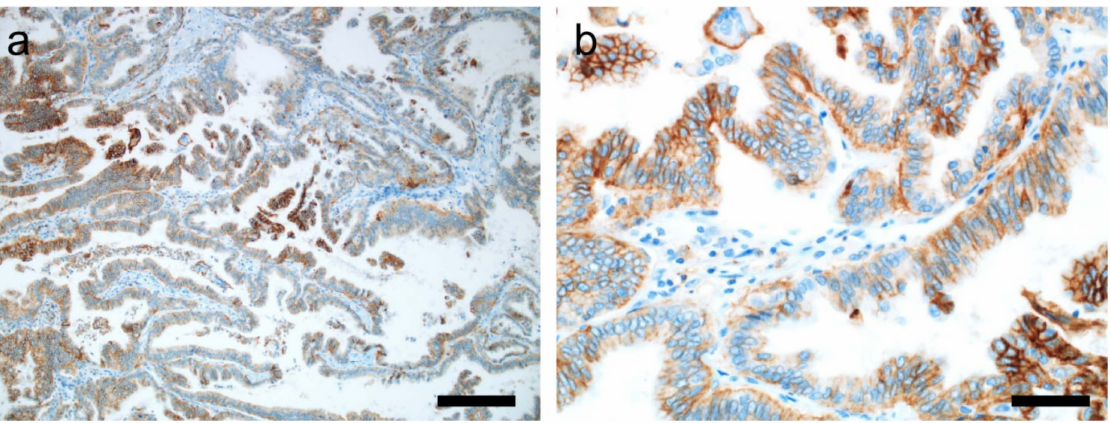
Figure 6. PD-L1 expression in papillary thyroid carcinoma. ( a ) Diffuse expression of PD-L1 on tumor cells ( × 100). ( b ) A high-power view shows the membranous staining for PD-L1 in cancer cells ( × 400). Scale bar = 50 µ